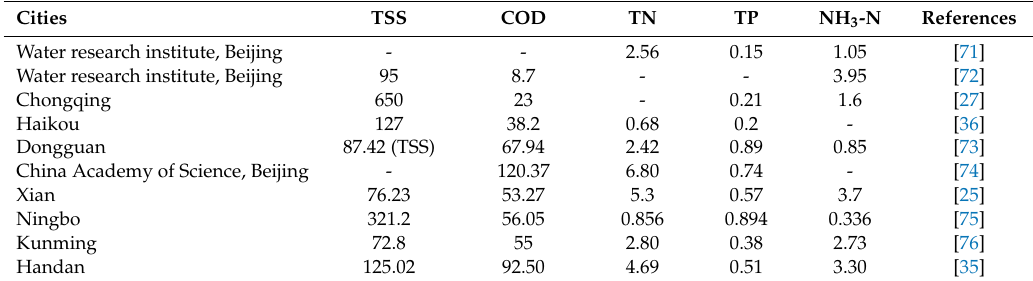
Table 5. The concentration of greenbelt stormwater runo ff (mg L − 1